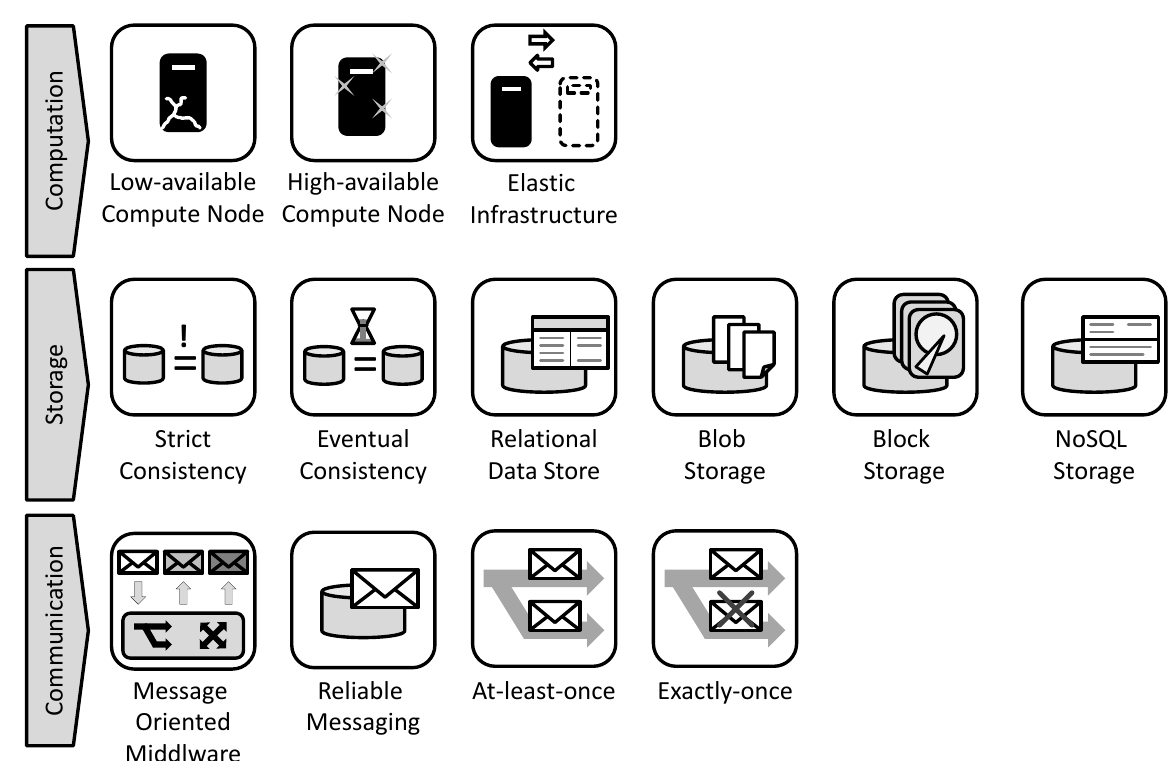
Figure 5. Icons of Cloud Offerings (adapted from